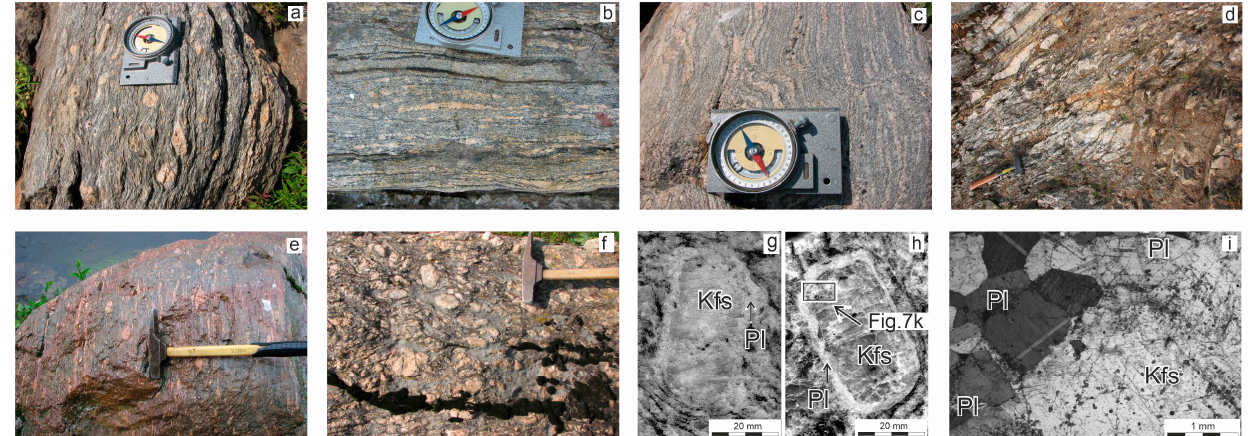
Figure 7. ( a ) Typical rocks of the Garevka complex: ( a ) porphyroblastic granite-gneisses; ( b ) blastomylonitic deformed granite-gneisses; ( c ) anatectic migmatites; ( d ) biotite plagiogneisses; ( e ) augen orthoclase granite-gneisses; and ( f ) metamorphosed rapakivi-type granites with ( g , h ) porphyritic ovoids of orthoclase segregations surrounded by a thin rim of plagioclase grains (marginal texture on thin section photo micrograph; crossed nicoles) ( i ).